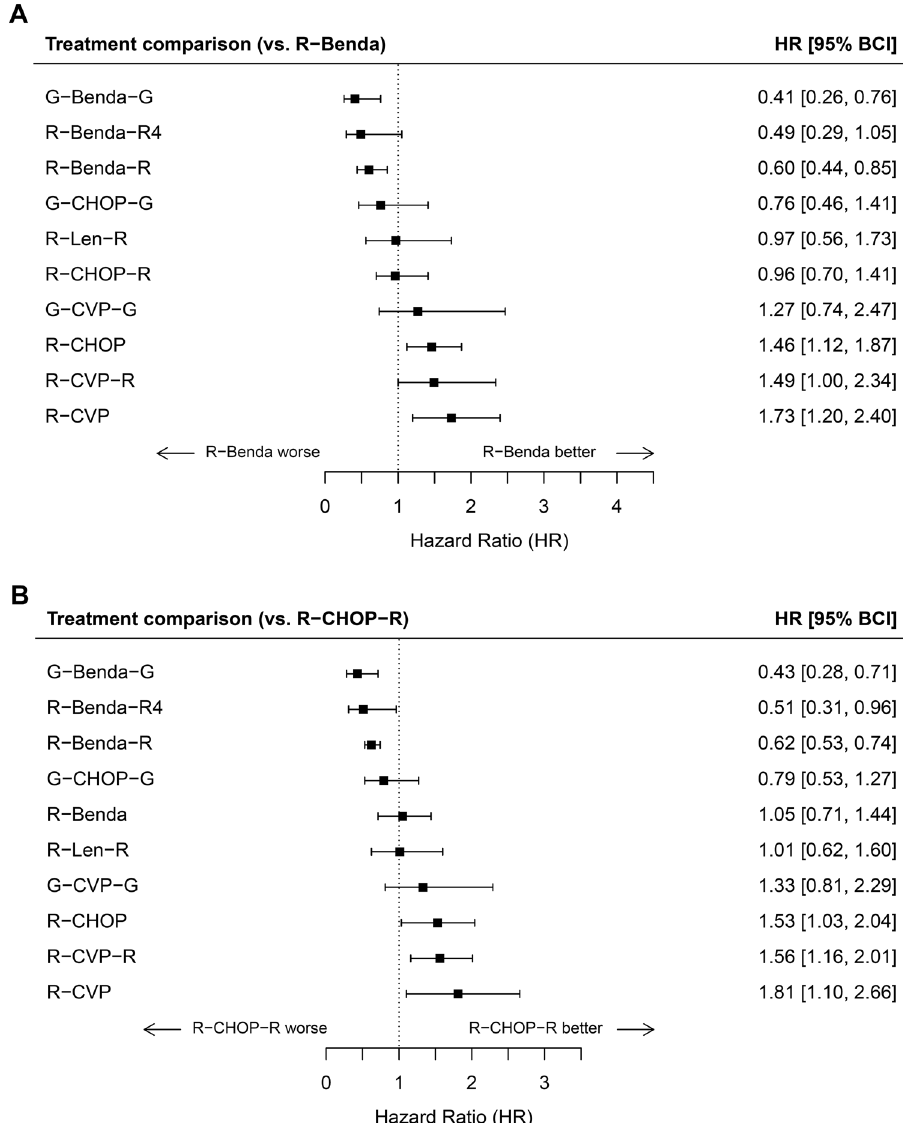
Fig. 4 Forest plot of network meta-analysis results. A Forest plot of hazard ratios for PFS of other regimens compared to R-Benda. B Forest plot of hazard ratios for PFS of other regimens compared to